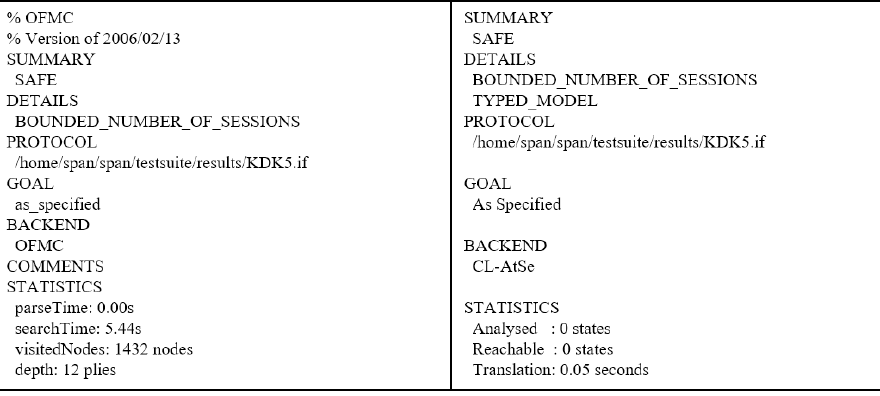
Figure 9. The AVISPA simulation result of the proposed